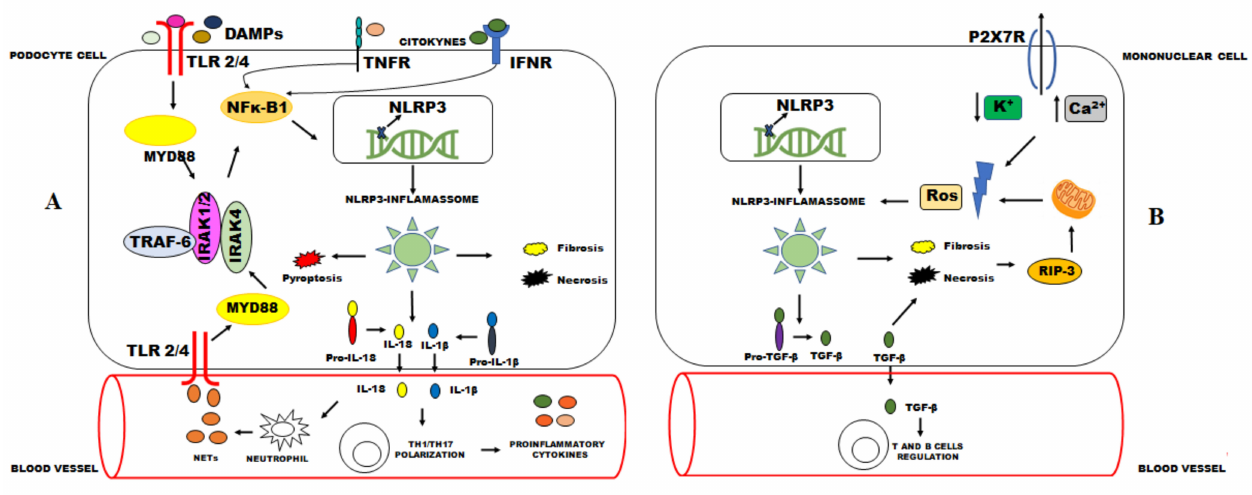
Figure 1. Possible mechanisms of NLRP3-inflammasome activation in podocytes and mononuclear phagocytes ( A ) and mononuclear phagocytes ( B ). ( A ): DAMPs and pro-inflammatory cytokines can activate the NLRP3 inflammasome via the NF κ -B signaling pathway. The increasing of NLRP3 transcriptions by NF κ -B induces the NLRP3-inflammasome activation. The NLRP3 inflammasome cleaves pro-IL-1 β and pro-IL-18 by caspase 1. These cytokines may cause kidney damage through an induction of inflammation and polarization of Th17 cells. IL-18 can also induce the formation of NETs by neutrophils, increasing stimuli by DAMPS. ( B ): A second signal provided by K + efflux and Ca 2+ flux mediated by P2X7 receptor induces Ros formation, enabling NLRP3-inflammasome activation. Similarly, necrosis and fibrosis promoted by NLRP3-inflammasome activation induce Ros formation through RIP3. These mechanisms together with the formation of TGF- β appear to contribute to kidney damage in LN. NLRP3: NLR pyrin domain-containing-3; TLR: Toll-like receptor; Myd88: Myeloid differentiation factor 88; TRAF-6: TNF receptor-associated factor 6; DAMPs: Damage-associated molecular patterns; IRAK-1: Interleukin 1 receptor-associated kinase 1; IRAK-4: Interleukin 1 receptor-associated kinase 4; NF κ -B: Nuclear factor kappa B; IL: Interleukin; Th: T helper; NETs: Neutrophil extracellular traps; K + : Potassium ions; Ca 2+ : Calcium ions; P2X7R: